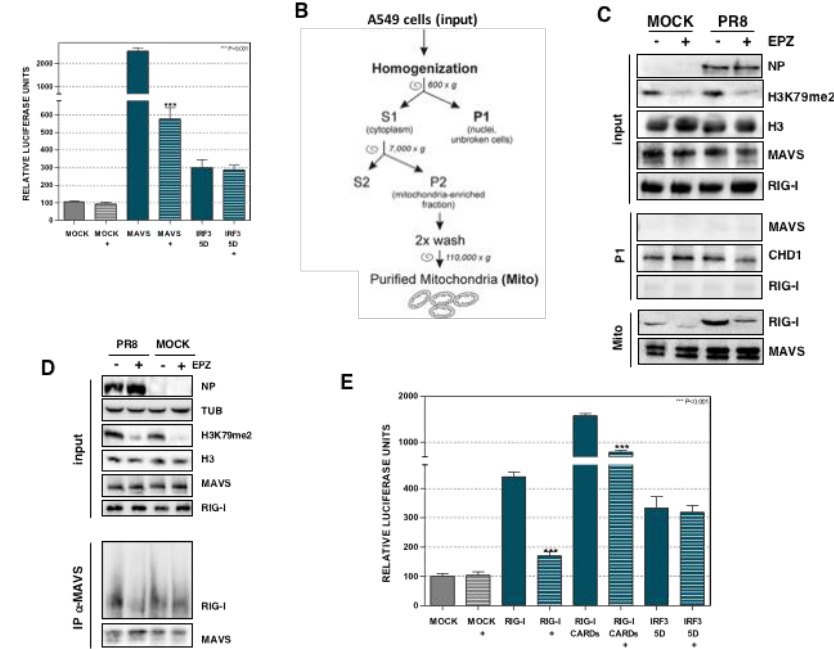
Figure 3. Dot1L modulates MAVS activation, RIG-I-MAVS association, and the antiviral response mediated by the RIG-I sensor. ( A ) A549 cells were left untreated (MOCK) or treated with 1 μ M EPZ ( + ), 48 h later the cells were transfected with pIF-LukTer (MOCK), or cotransfected with pIF-LukTer together with plasmids expressing MAVS (MAVS), or mutant IRF3 (IRF3 5D) and the luciferase activity was evaluated at 16 hpt. ( B ) Scheme of the mitochondria purification. ( C ) Control or EPZ-treated cells were left uninfected (MOCK), or infected with PR8 virus at MOI 3 for 8 h. Input, P1 (P1), and purified mitochondria (Mito) fractions were used for Western blot analysis against the indicated proteins. ( D ) Control or EPZ-treated cells (1 µ M ( + ), 48 h) were left uninfected (MOCK), or infected with PR8 virus at MOI 3 (PR8). At 16 hpi, the total extract was used for immunoprecipitation analysis using antibodies against MAVS. The immunoprecipitate was used for Western blot analysis against the indicated proteins. ( E ) Control or EPZ-treated cells were transfected with pIF-LukTer (MOCK), or cotransfected with pIF-LukTer, together with plasmids expressing RIG-I (RIG-I), or RIG-I 2CARDs (RIG-I CARDs), or mutant IRF3 (IRF35D) and the luciferase activity was evaluated at 16 hpt. In panels A and E, the luciferase activity was normalized by Renilla luciferase. The MOCK condition without EPZ treatment was taken as 100%. Three technical replicates of three independent experiments were analyzed. ns p > 0.05; * p < 0.05; ** p < 0.01; *** p < 0.001.